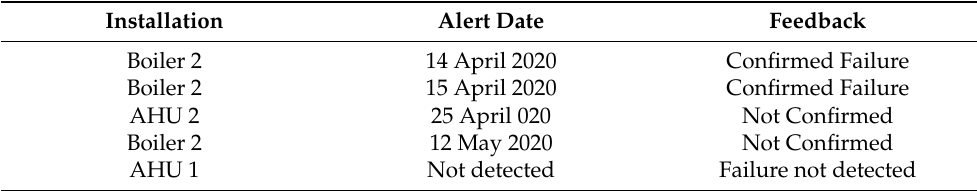
Table 2. Summary of faults alerts during the test